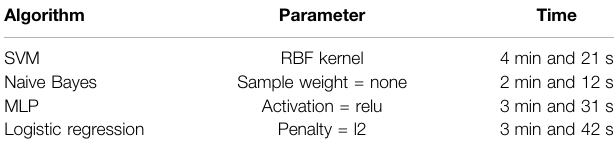
TABLE 2 | Parameters of ML algorithms.